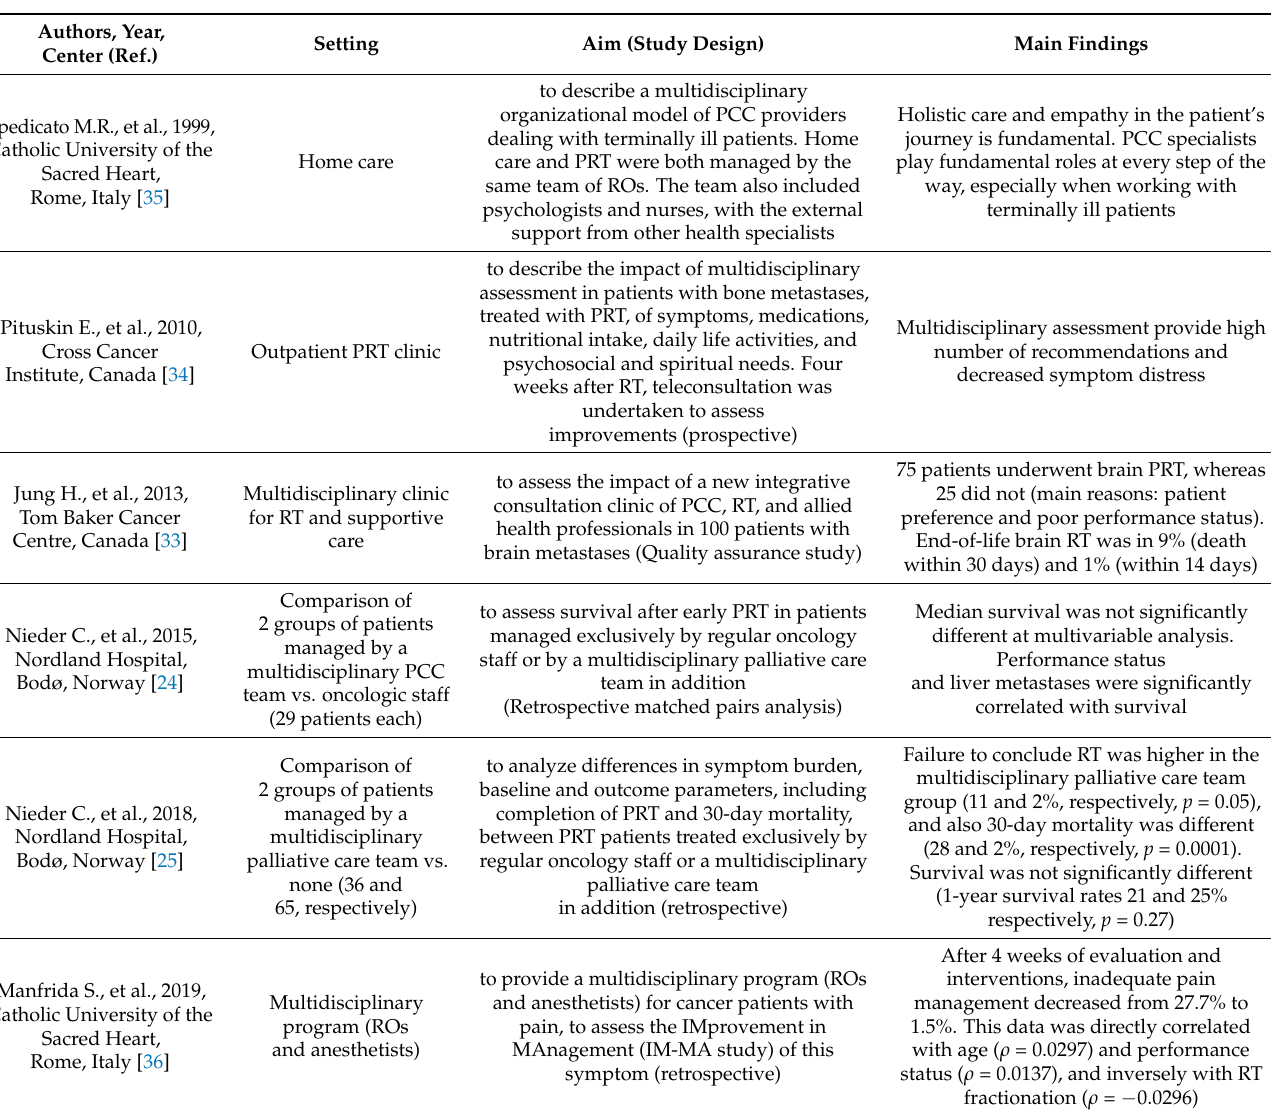
Table 2. Characteristics and main findings on studies about integration of palliative radiotherapy